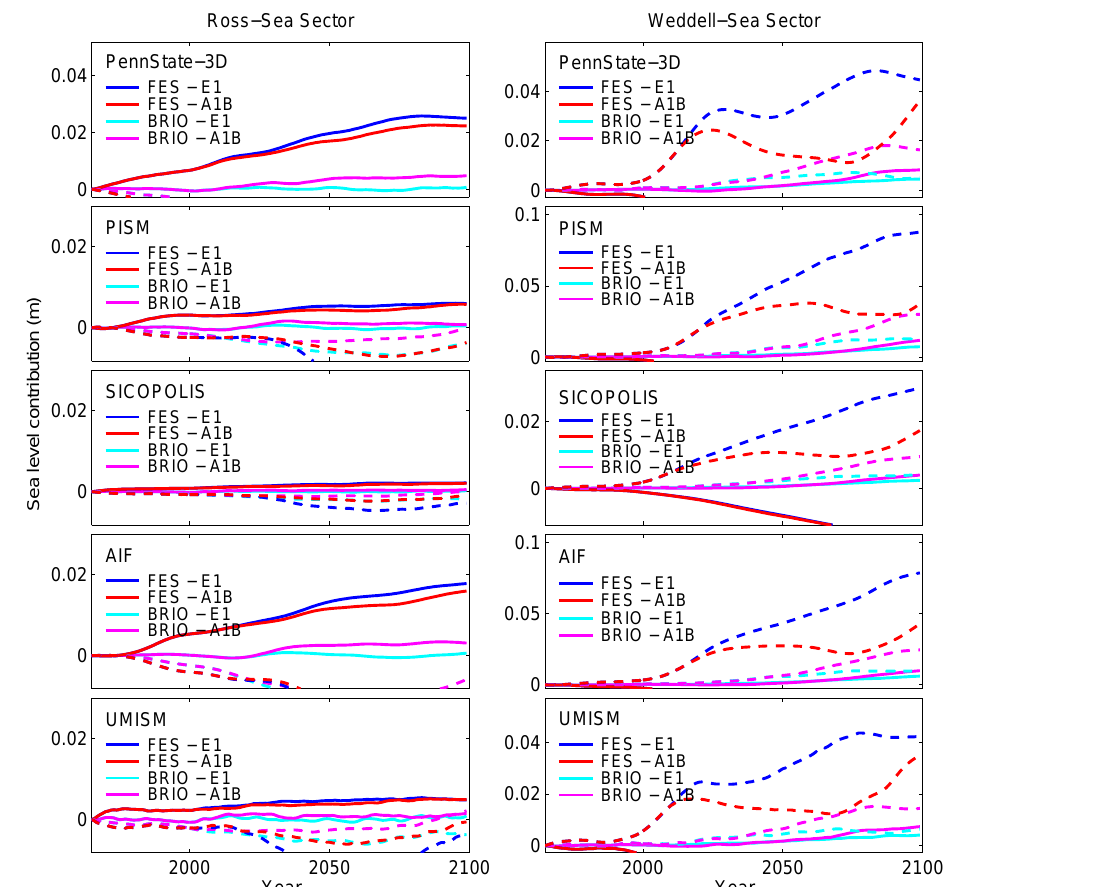
Figure 6. Ice loss as obtained from forcing the five response functions (Fig. 3) with the basal melt rates from the high-resolution global finite-element model FESOM (FES) and the regional ocean model BRIOS (BRIO). The full lines represent simulations in which BRIOS and FESOM were forced with the global climate model ECHAM-5; dashed lines correspond to a forcing with the HadCM-3 global climate model. Results are shown for the strong climate-change scenario A1B and the relatively low-emission scenario E1. A medium basal melt sensitivity of 11.5ma − 1 K − 1 was applied. The results illustrate the important role of the global climatic